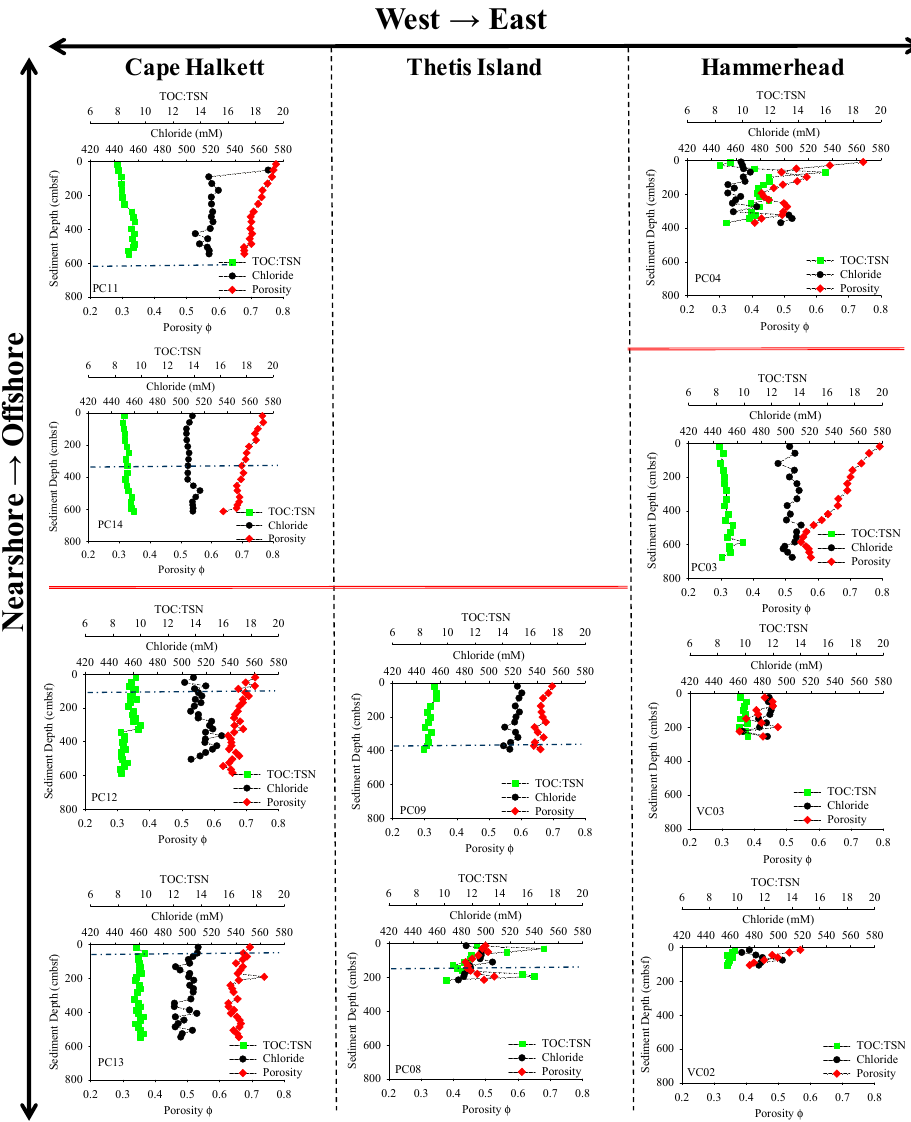
Figure 2. Measured sediment organic carbon to total nitrogen ratios (TOC:TSN); porewater chloride (mM), and sediment porosity ( φ ) plotted vs. depth (cm) in the sediment below seafloor (cmbsf) for sediment cores collected along the North Slope of Alaska on the Beaufort Sea. Sediment core profiles are separated into three distinct sampling transects (Cape Halkett, Thetis Island and Hammerhead) and displayed by relative location west-to-east (left-to-right) and offshore-to-nearshore (top-to-bottom) on the North Slope. The blue dashed line presented in plots with a measured SMT represents the depth reported in Table 1. The red line in each transect indicates the relative location of the shelf-break for each coring transect (Figure 1).